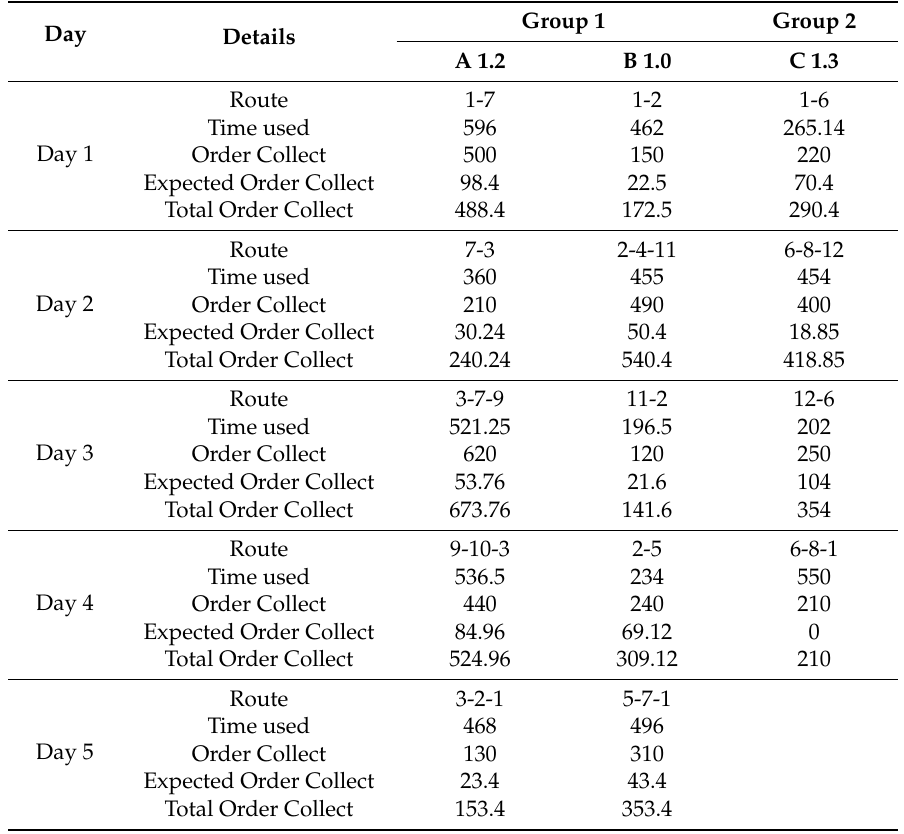
Table 2. The schedule and route planning of 12 customers and three